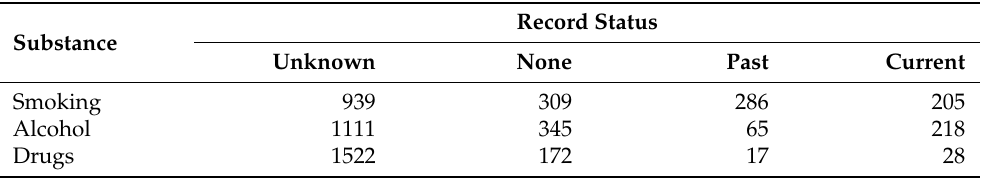
Table 3. Annotation summary in terms of number of records for the substance-use statuses of the dataset’s discharge